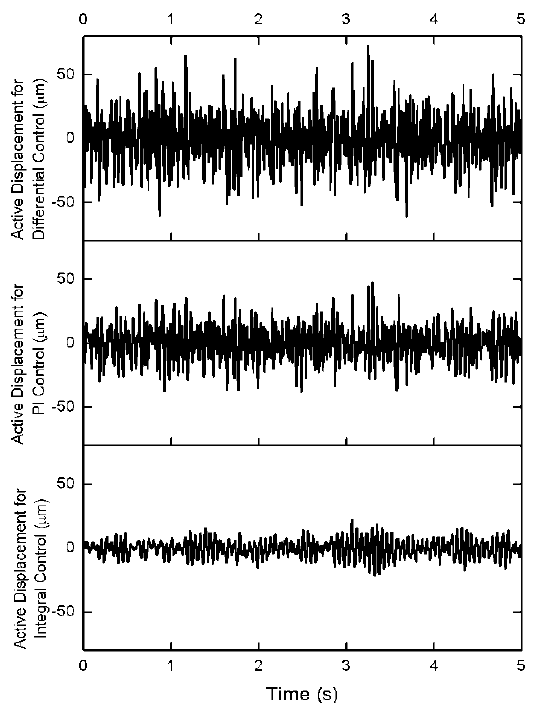
Figure 7. Active displacements on the cable 3.